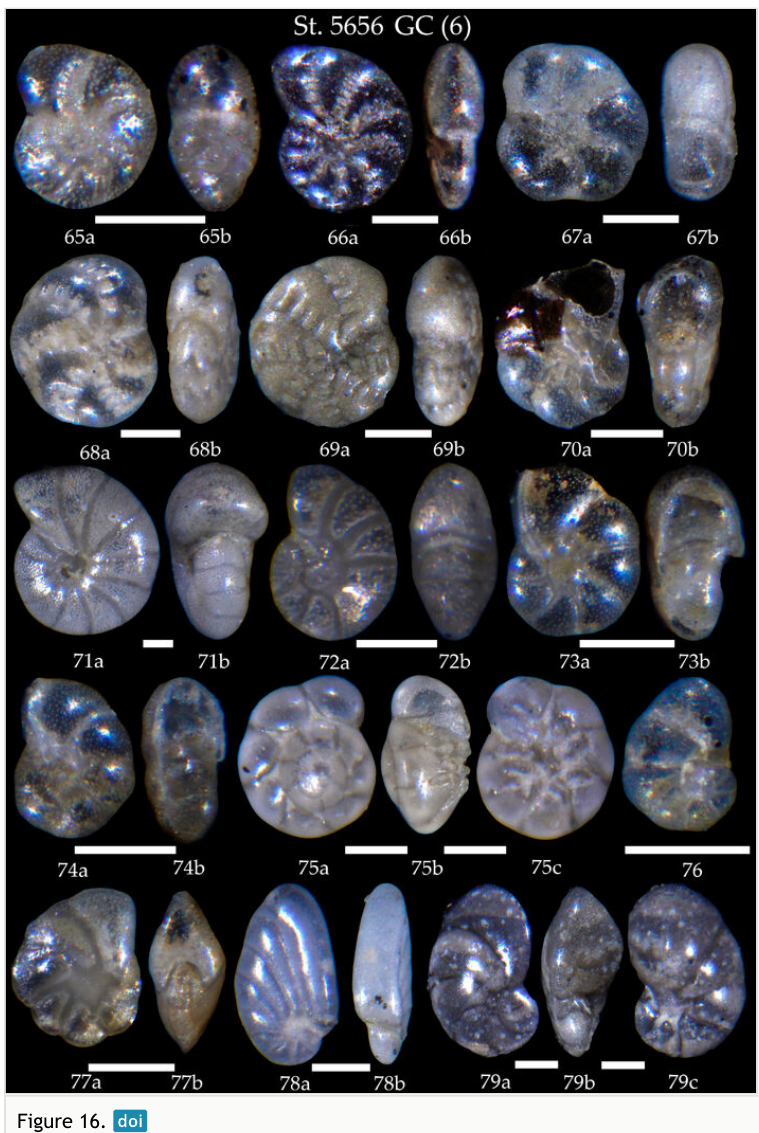
Figure 16. Station 5656 GC (continued). 65 Elphidium clavatum , a side view, b apertural view; 66 Elphidium gerthi , a side view, b apertural view; 67 Elphidium sp. cf. E. magellanicum , a